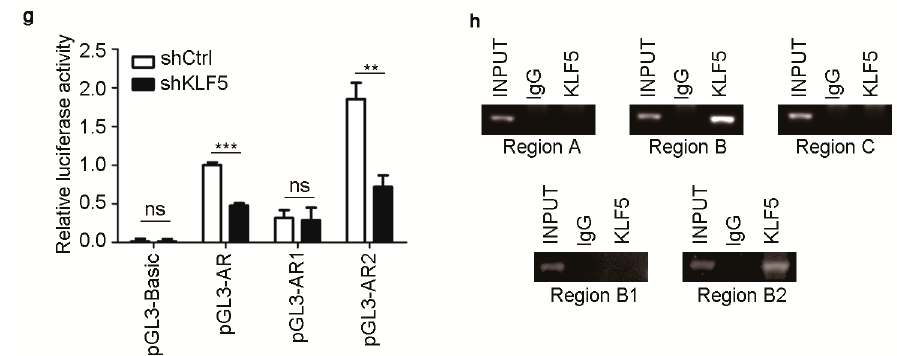
Figure 3. KLF5 is required for the transcription of AR in PCa cells. ( a – d ) Knockdown of KLF5 decreased AR expression at both protein (a, c) and RNA (b, d) levels in LNCaP (a-b) and C4-2B cells (c–d). Cells were cultured in complete media for 24 h and transfected with siRNAs for 48 h in LNCaP cells or infected with lentiviruses expressing shRNA targeting KLF5 (shKLF5) in C4-2B cells. Western blotting and real-time qPCR were performed to detect protein and mRNA respectively. ( e ) The AR promoter contains multiple potential KLF5 binding sites, as predicted by aligning the 2-Kb immediate promoter sequence of AR to the consensus KLF5 binding sequence (top) defined in the JASPAR database. Location of these sequences relative to the transcription initiation site ( + 1) is shown at left. ( f ) Schematic of the AR promoter region ( − 2000 to + 200) with the locations of predicted KLF5 binding sites (empty oval) and primers used for PCR amplification of 5 regions (A, B, C, B1, B2) of the AR promoter spanning the potential binding sites. ( g ) Knockdown of KLF5 decreased AR promoter activity in C4-2B cells, as detected by the luciferase activity assay. The pGL3 vector was used to express full-length AR promoter (g, pGL3-AR, from − 2000 to + 200) and two shorter AR promoter fragments (pGL3-AR-1, − 2000 to − 500; pGL3-AR-2, − 500 to + 200), with their luciferase readings normalized by that of the pGL3-Basic vector control. ( h ) Detection of KLF5-bound AR promoter DNA in C4-2B cells using ChIP and PCR. ns, not significant; *, p < 0.05; **, p < 0.01; *** p <